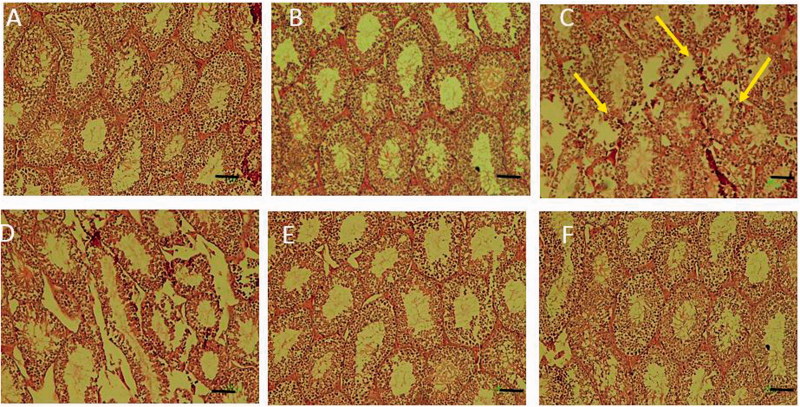
Histological examinations of tubules in the testis of (A) control, (B) sham (RD40), (C) FA, (D) RD10 + FA, (E) RD20 + FA and (F) RD40 + FA groups. Abnormal and barren testicular seminiferous without spermatozoa were observed in germinal epithelium of FA group. In FA and RD + FA groups, the diameters of testicular seminiferous and epithelial tubules significantly decreased compared to the control group. However, in the ‘FA + RD’ groups, the diameters of seminiferous and epithelial tubules increased compared to the FA group. Scale bar =100 µm.